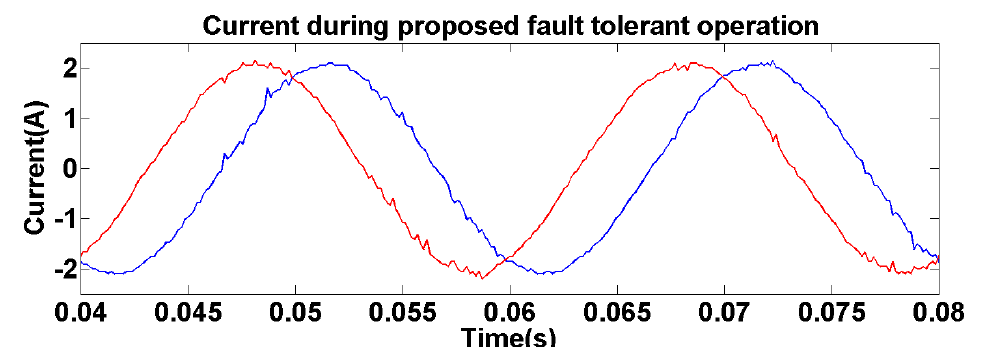
Figure 13. Current after fault with proposed